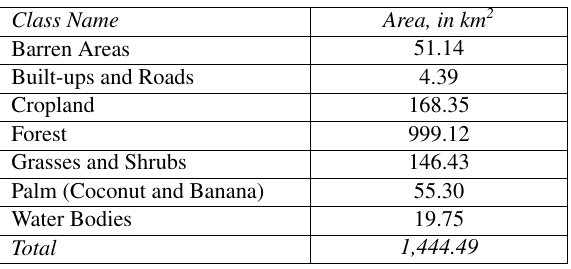
Table 2: Area per land-cover class in Tago river basin